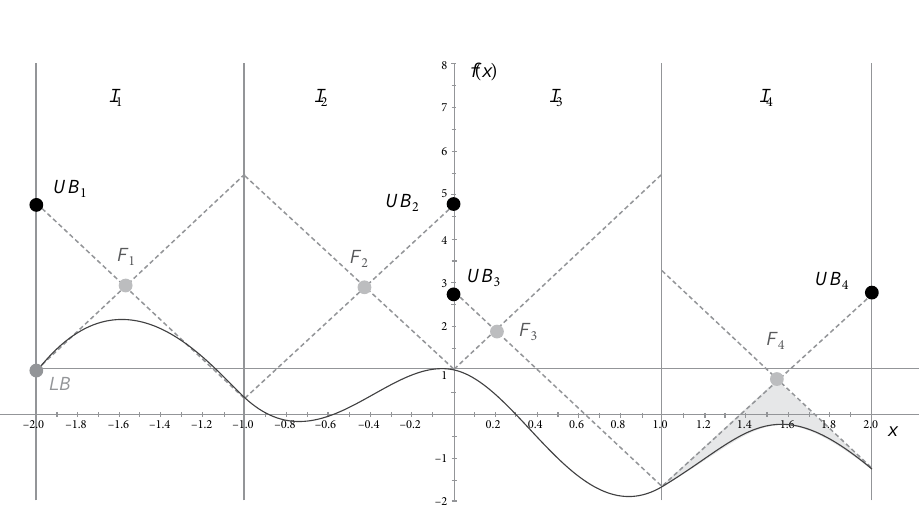
Fig. 3. Second step of branch-and-bound with simplicial partitions with n =